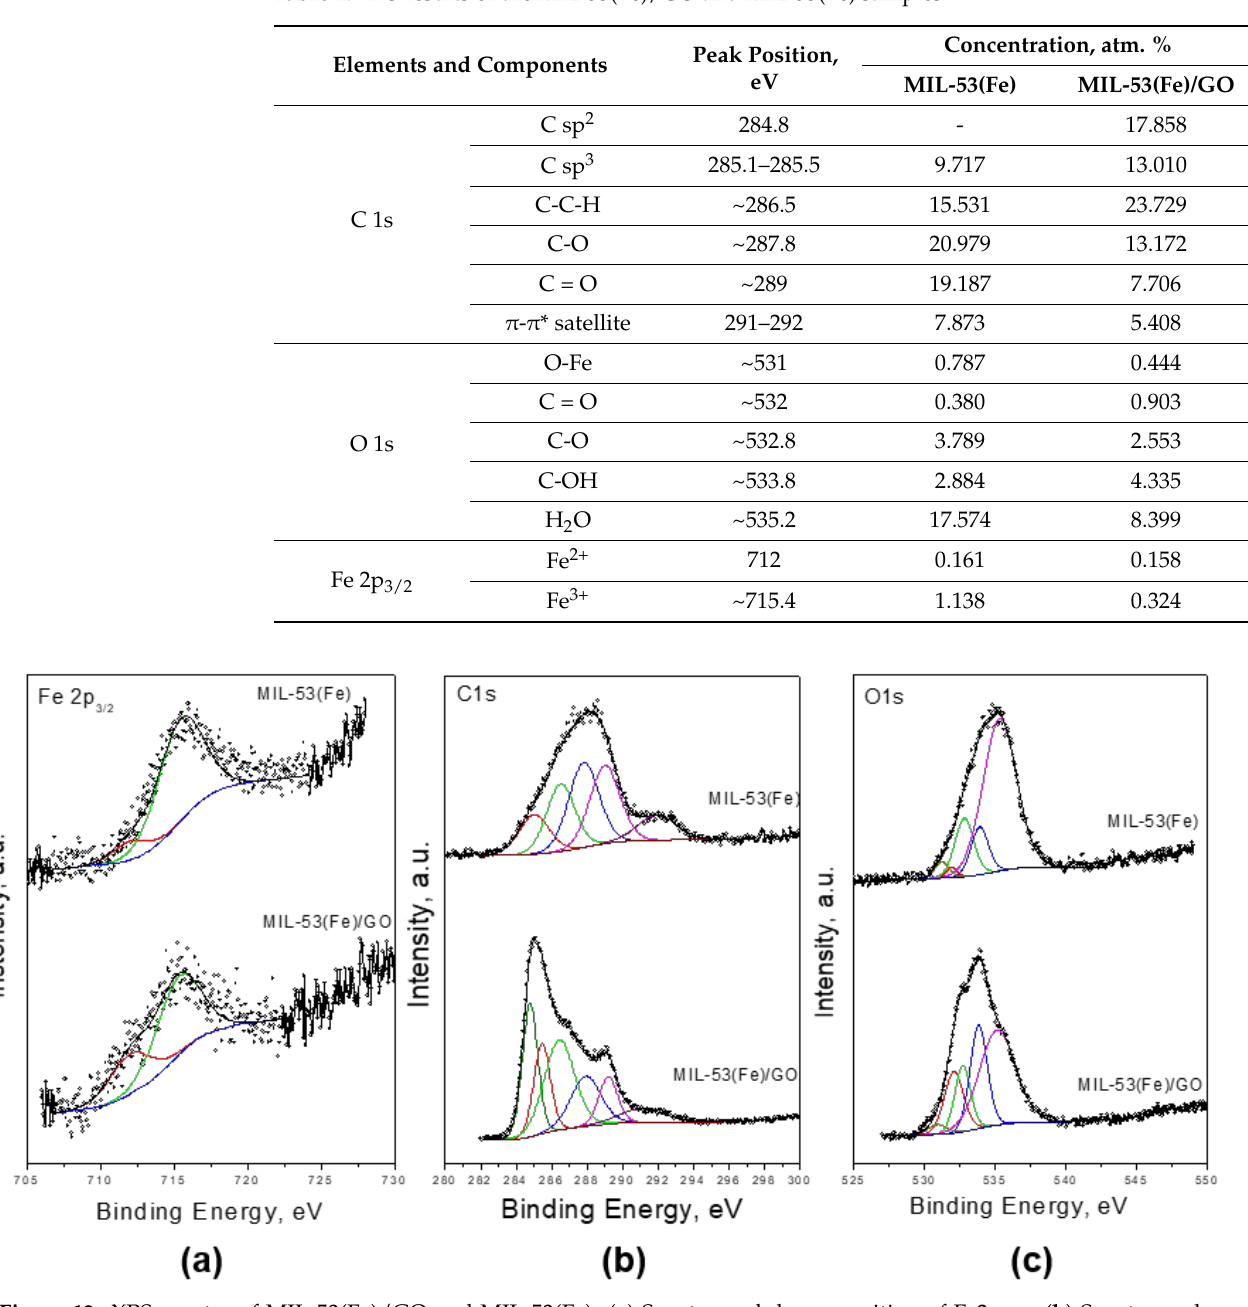
Figure 12. XPS spectra of MIL-53(Fe)/GO and MIL-53(Fe): ( a ) Spectra and decomposition of Fe2p 3/2 , ( b ) Spectra and decomposition of C1s, ( c ) Spectra and decomposition of O1s.